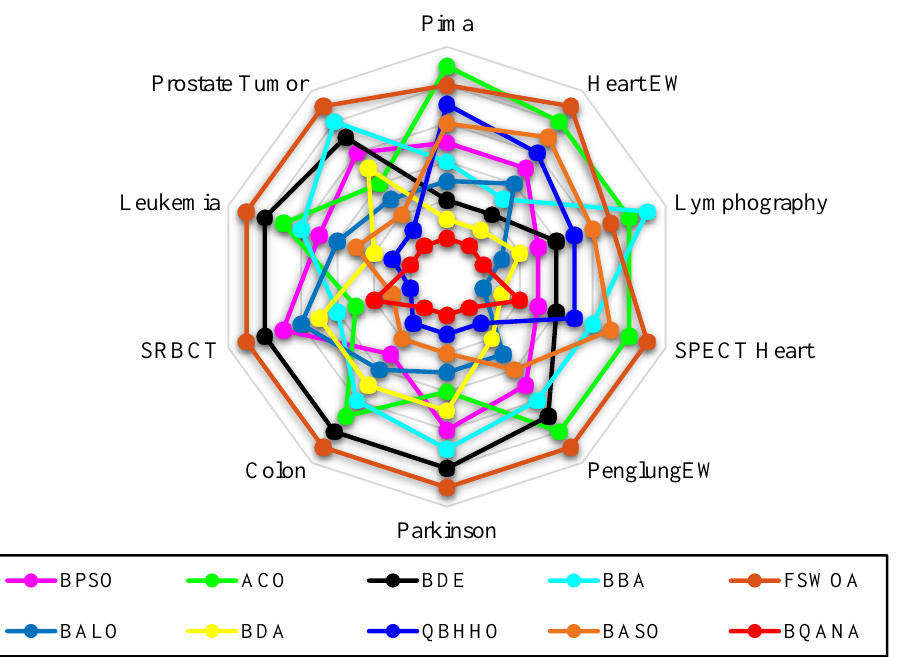
Figure 10. The rank of BQANA and comparative algorithms for feature selection problems.